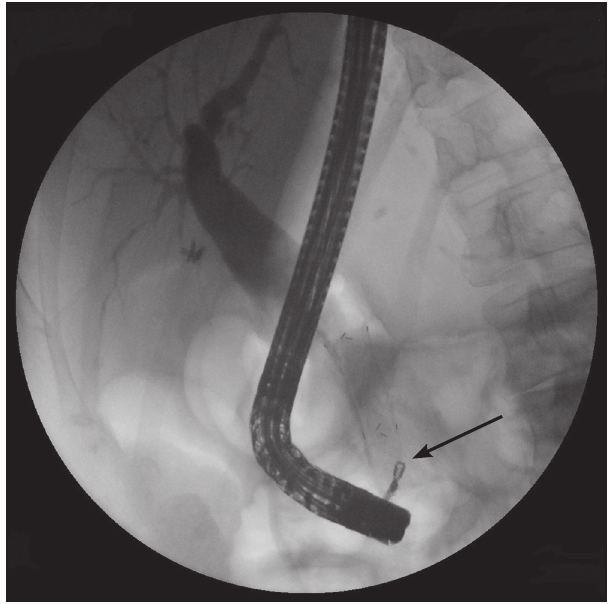
Figure 2) Fluoroscopy image during stent removal showing rat-tooth forceps grasping the distal end of the fractured stent